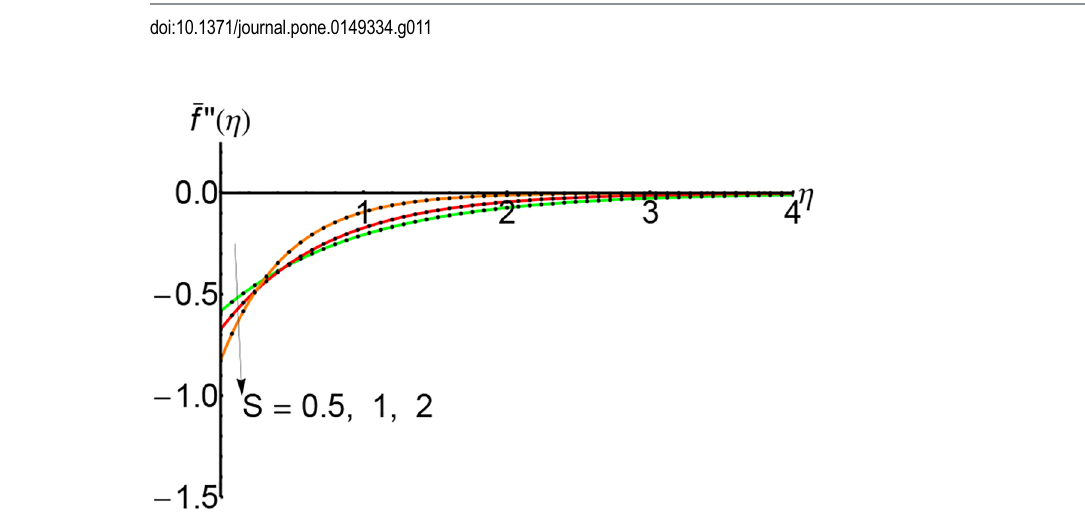
Fig 12. Variation of shear stress (cid:2) f 00 ð Z Þ with η for different values of suction parameter S and for λ = 0.75: —— numerical solution ......... . OHPM solution.